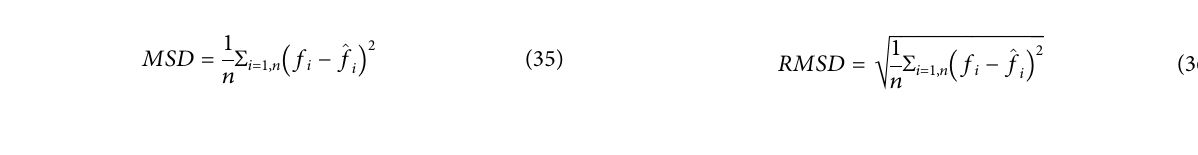
Frontiers in Future Transportation |